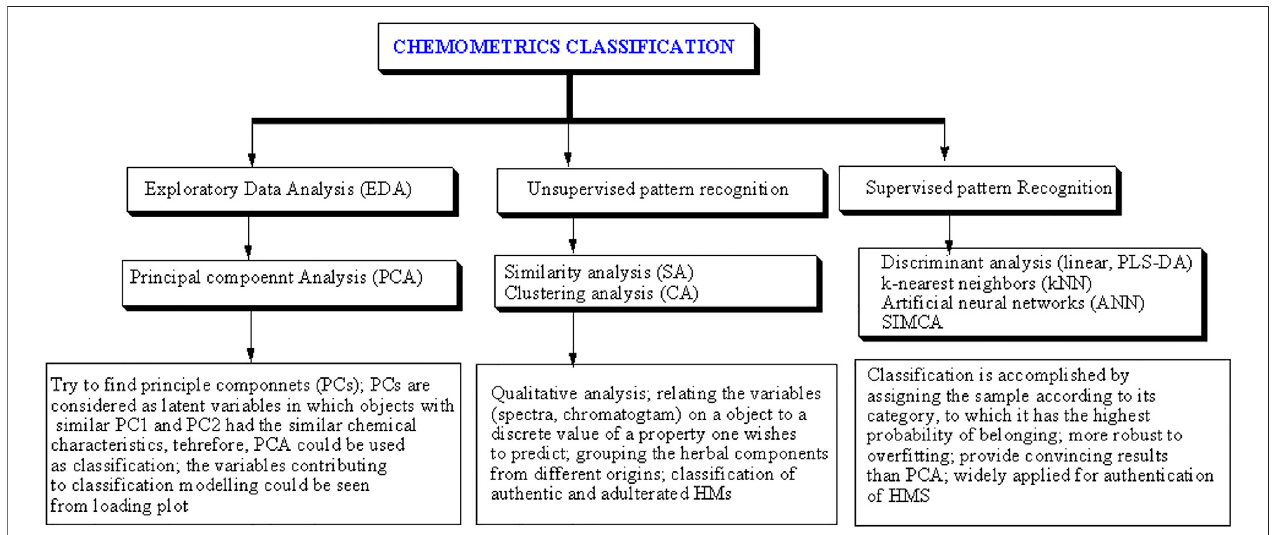
FIGURE1| Thechemometricsclassi fi cationtechniqueswidelyappliedfortheidenti fi cationofobjects.Reproducedfrom(RohmanandWindarsih,2020)underthe termsand conditionsoftheCreativeCommonsAttribution (CCBY)license.PLS-DA=partialleastsquaresdiscriminantanalysis,SIMCA =softindependentmodelingof class